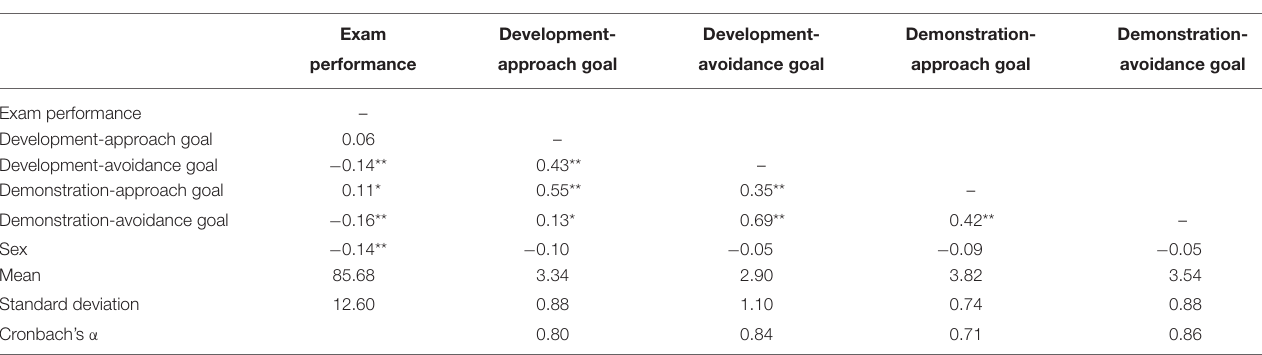
TABLE 5 | Study 3: intercorrelations and descriptive statistics.